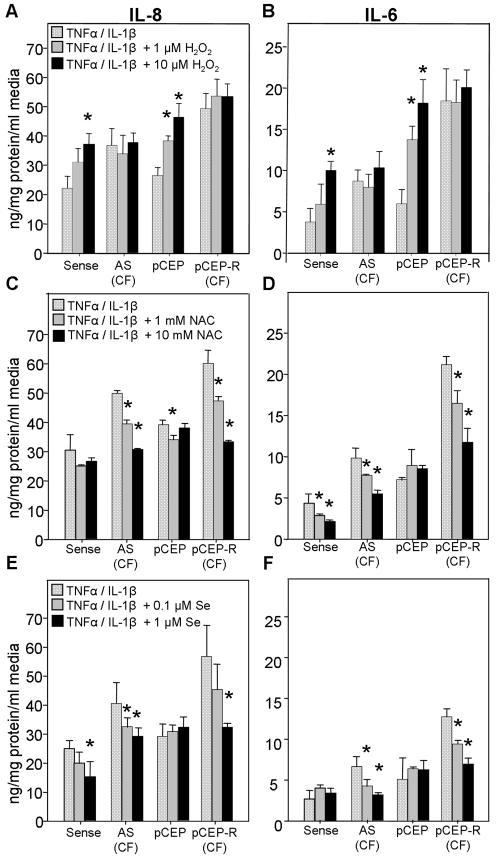
H2O2 and antioxidants significantly modulate the production of IL-6 and IL-8 in cells stimulated with TNFα/IL-1β.Normal and CF matched pair cell lines were stimulated for 1 hr. with TNFα/IL-1β (10 ng/ml each) and then cultured for 24 hrs. in the absence, or presence of 1 µM or 10 µM of H2O2, 1 mM or 10 mM N-acetyl cysteine (NAC), or 0.1 µM or 1 µM selenium (Se). * connotes significant difference (p<0.05) from untreated control (spotted white bars). Each data bar represents the average of 8 replicate wells in 3 experiments for A–F.